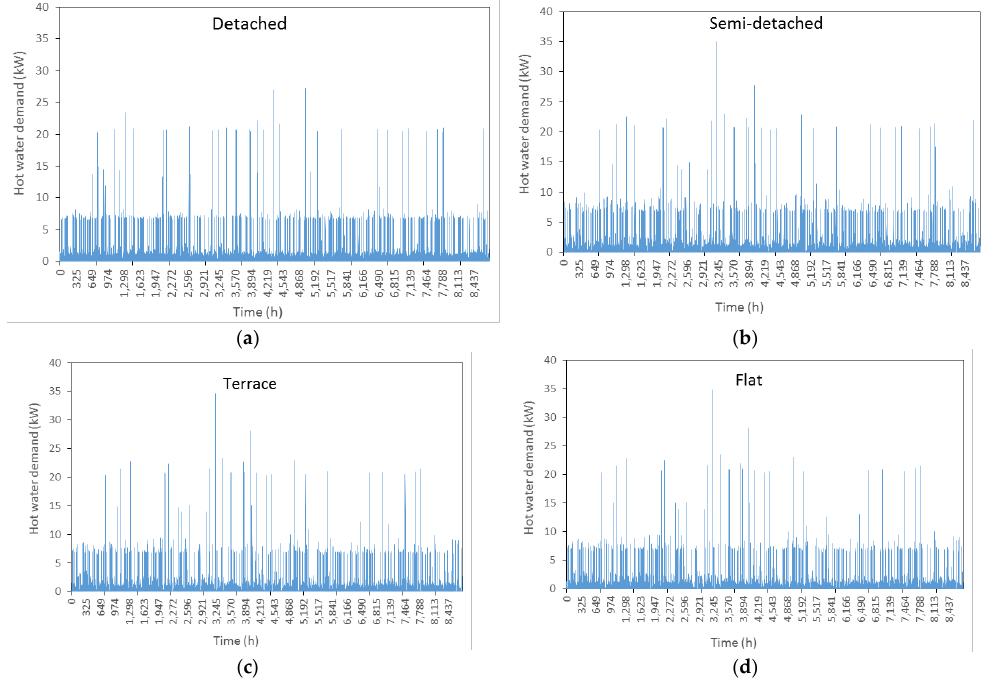
Figure 3. Hot water demand for all house types: ( a ) Detached; ( b ) Semi-detached; ( c ) Terrace; ( d ) Flat.